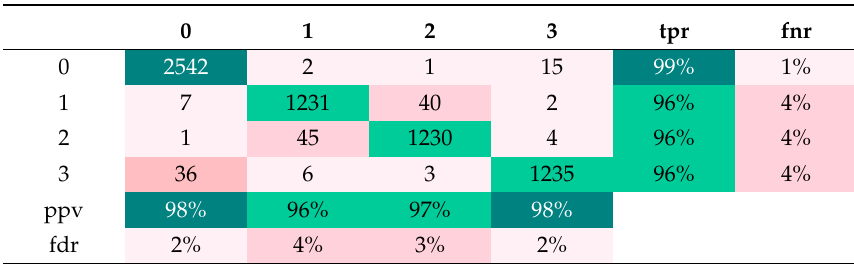
Figure 8. Performance measures (per-unit) corresponding to the Gaussian SVM strategy for the multiclass classification problem for a box constraint C = 50 and with respect to the kernel scale γ (horizontal axis). Table 9. Confusion matrix for the Gaussian SVM algorithm for the case C = 50 (box constraint) and γ = 1 (kernel